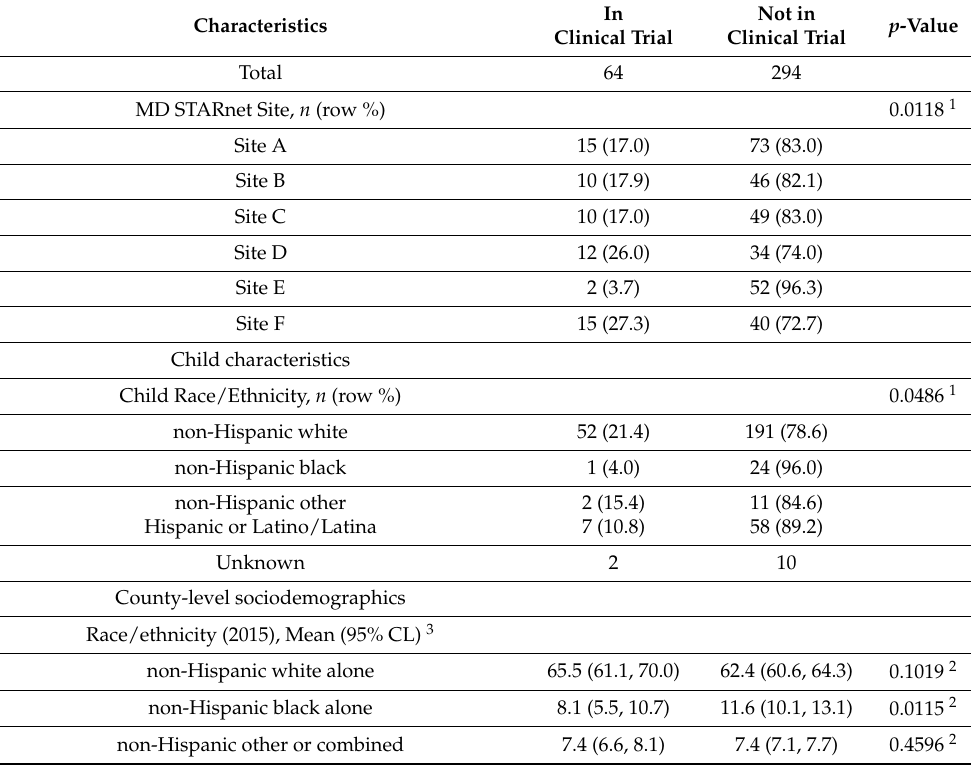
Figure 4. Frequency percentages for calendar year of initial documentation of enrollment in a clinical trial, the Muscular Dystrophy Surveillance, Tracking, and Research Network (MD STAR net ), 2000–2015. Note: Year of use was missing for non-steroidal clinical trial medication ( n = 1). Table 2. Sample characteristics by any clinical trial participation in the Muscular Dystrophy Surveil- lance, Tracking, and Research Network (MD STAR net ),